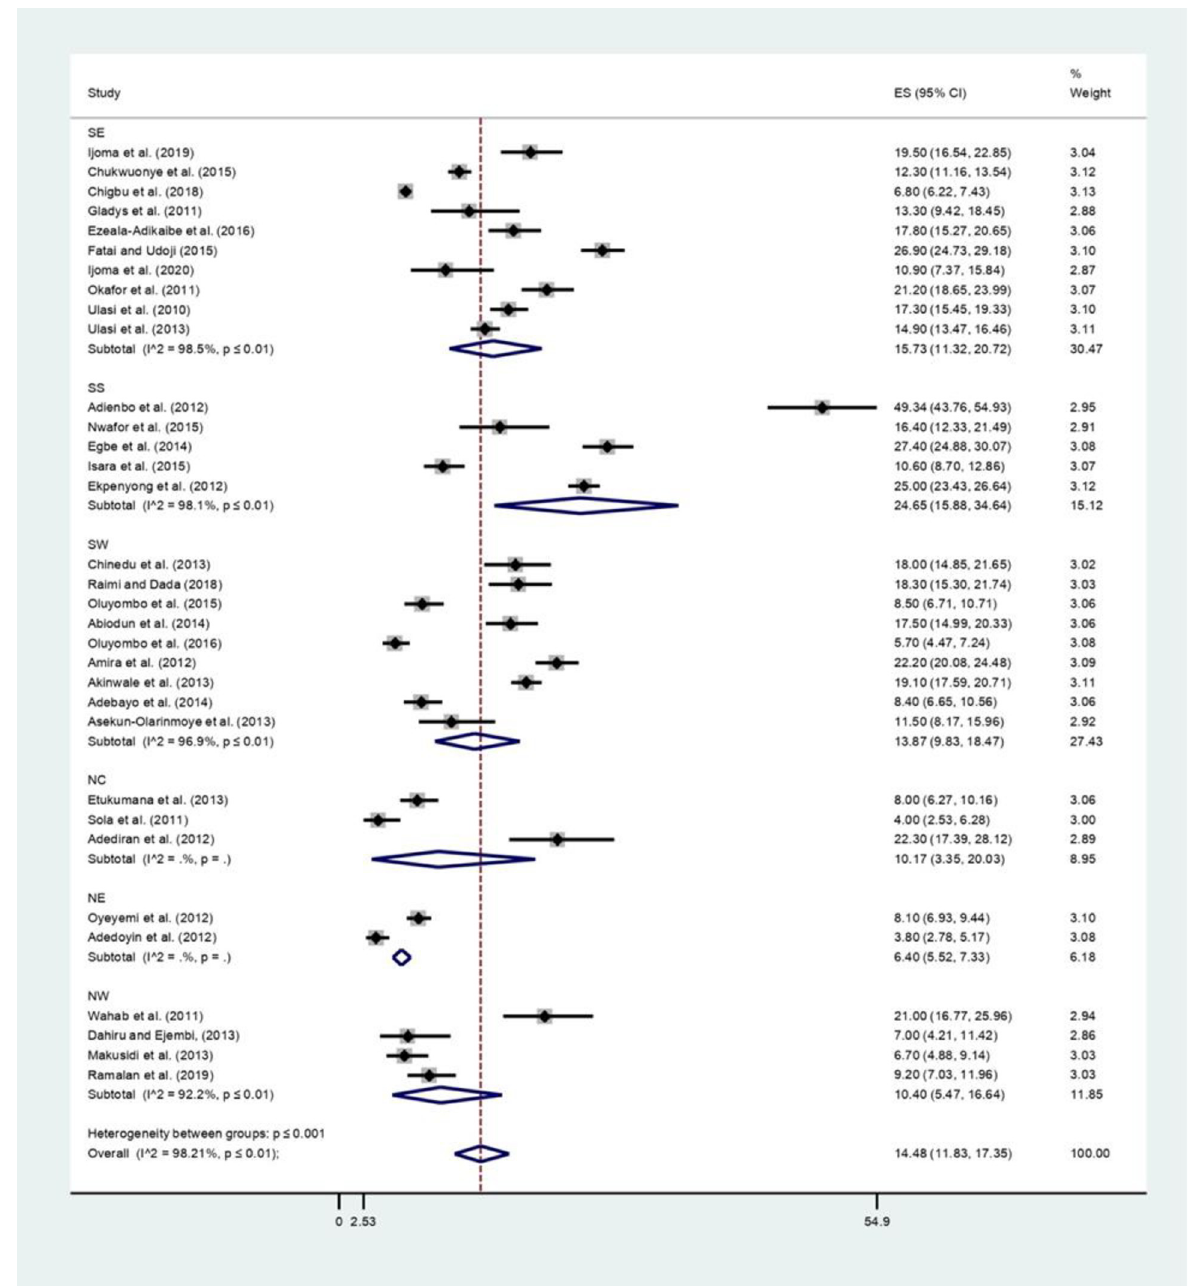
Fig 5. The prevalence of obesity among adults in the six geopolitical zones of